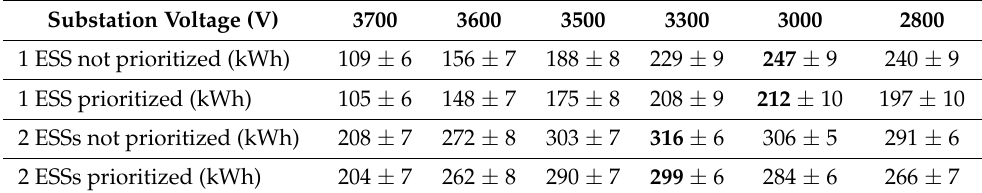
Table 2. Net amount of saved energy for the whole